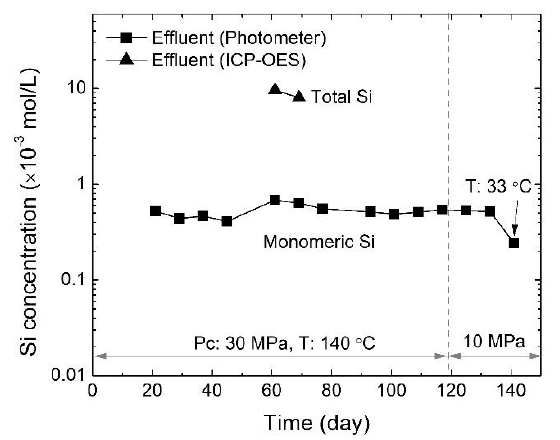
Figure 7. Evolution of maximum Si concentration of each series of effluent subsamples as a function of time and under different confining pressure and temperature conditions.